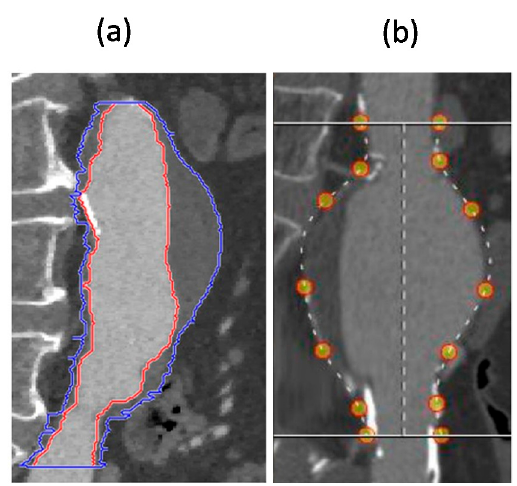
Figure 8. Example of aneurysm segmentation provided by: ( a ) EVAR-eaSE software using an automatic seeded region grow algorithm starting from inside; ( b ) 3Mensio requiring manual selection of markers on the external sac profile.